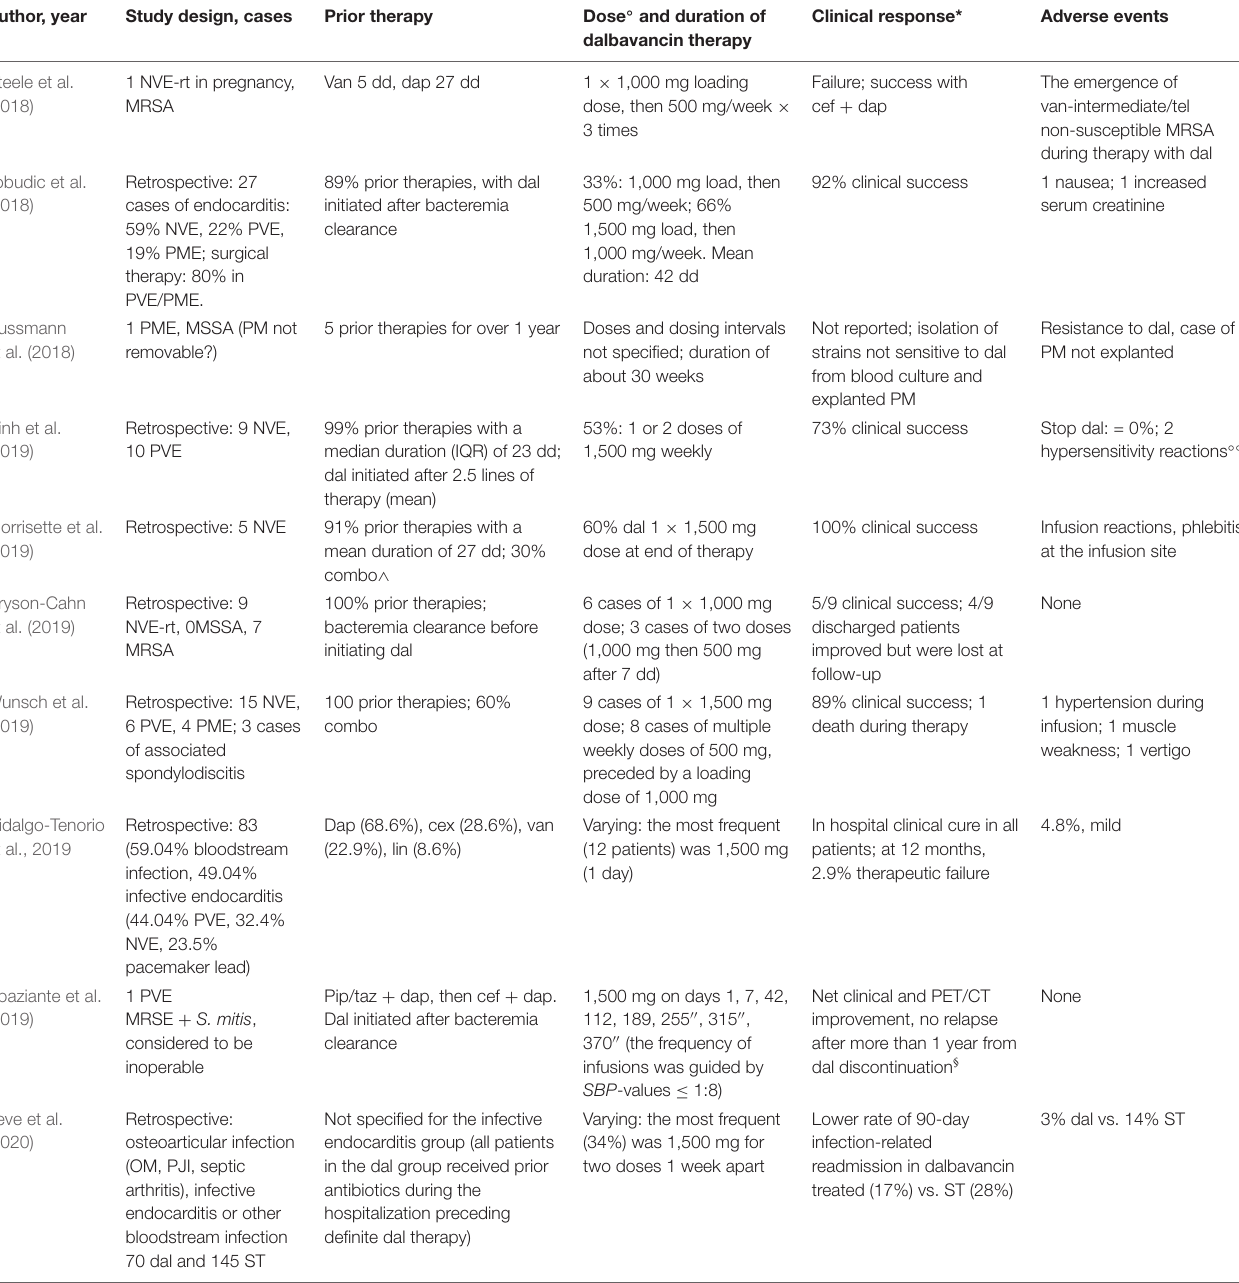
TABLE 3 | Dalbavancin in the treatment of infective endocarditis: an analysis of the